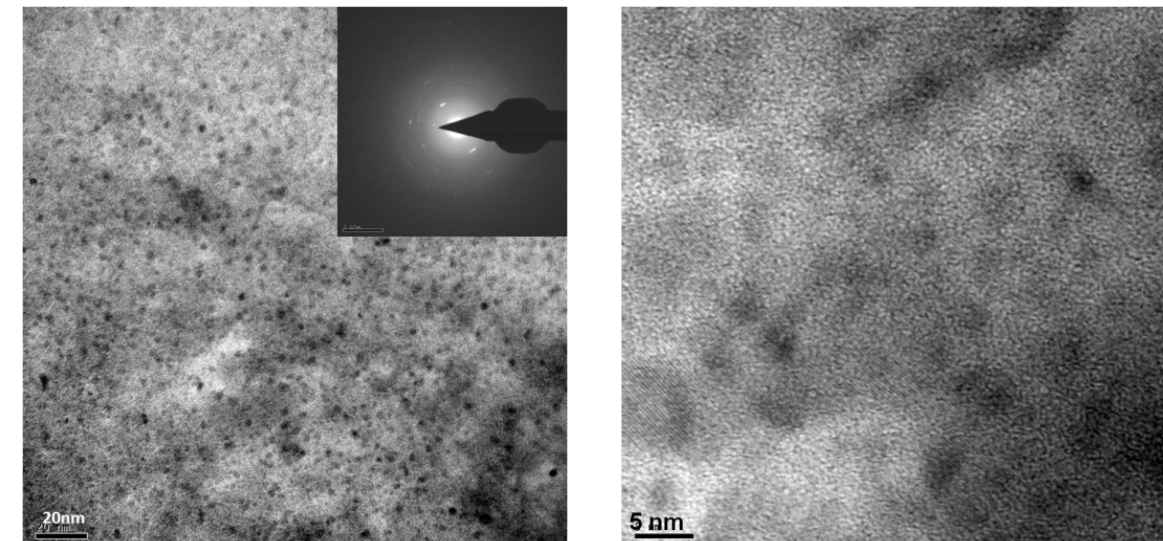
Figure 23: TEM Picture of TiSiBC hard coating deposited by Magnetron sputtering [268]